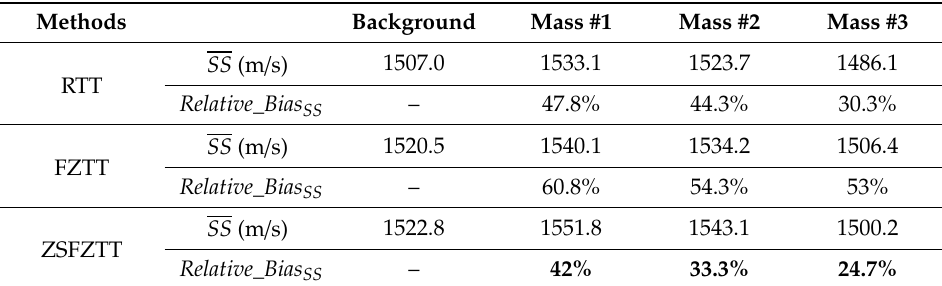
Table 4. The Relative _ Bias SS measured on SS image of numerical phantom reconstructed by RTT, FZTT, and ZSFZTT methods.